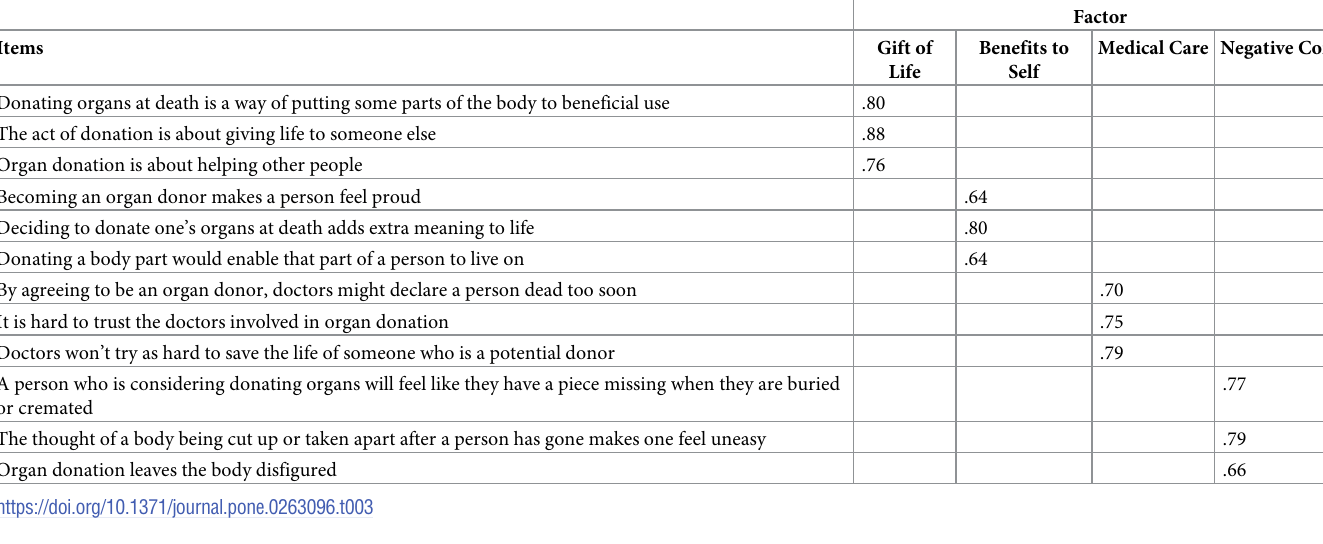
Table 3. Standardized factor loadings for 12 items of the 4-factor